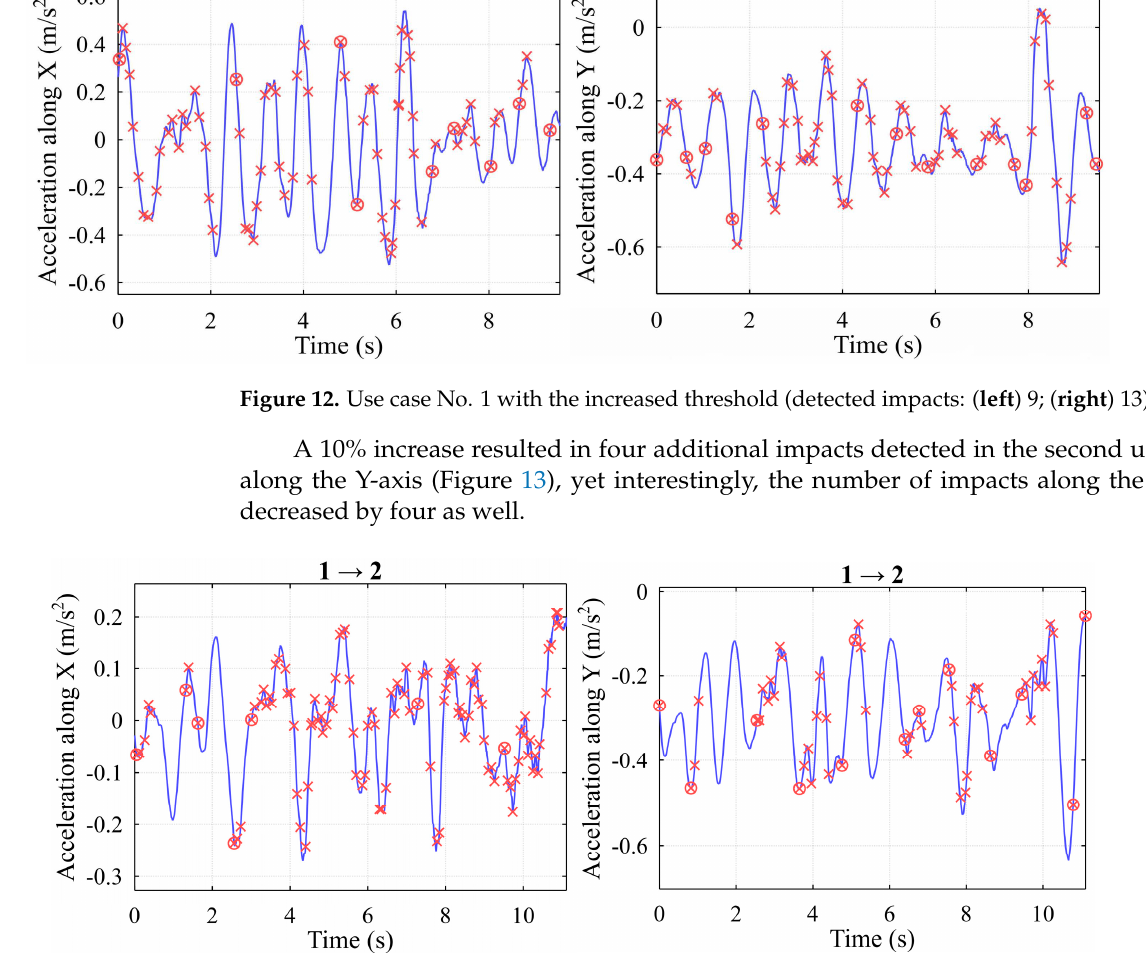
Figure 13. Use case No. 2 with the increased threshold (detected impacts: ( left ) 7; ( right ) 13).